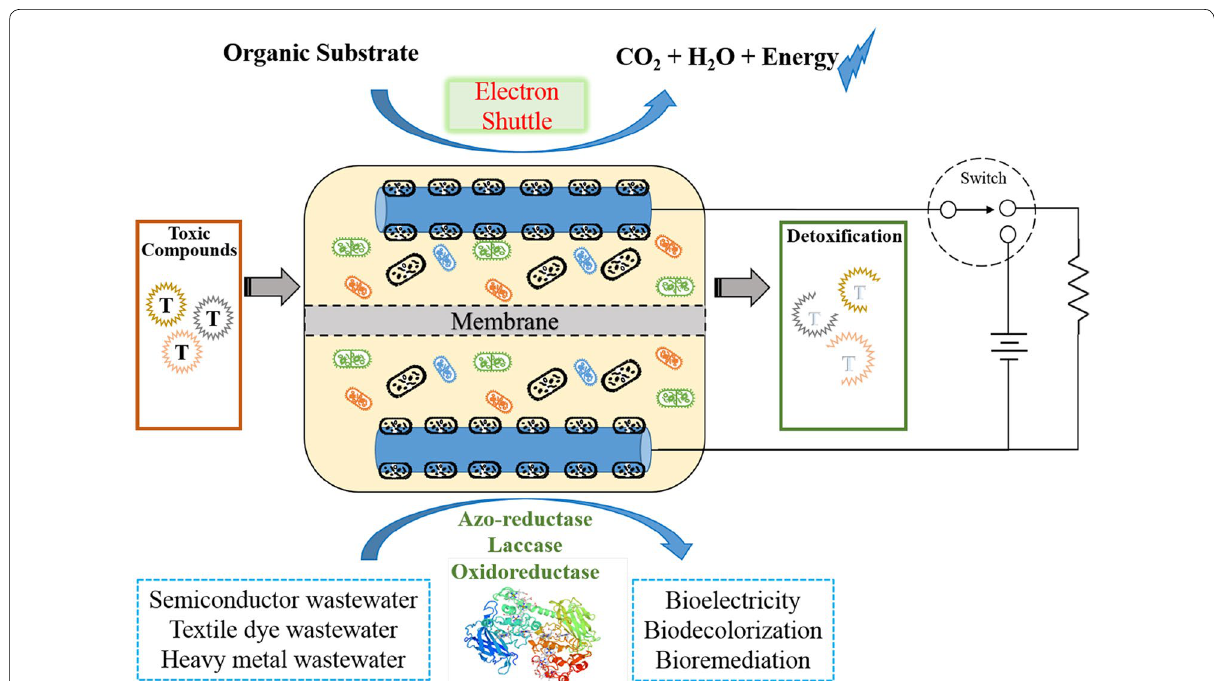
Fig. 6 Proposed microbial fuel/electrolysis cell technology via electro‑fermentation for wastewater treatment. Due to applications of electric current to achieve new redox balancing, electrochemically steered wastewater treatment for bioelectricity generation, dye decolorization, and pol‑ lutant bioremediation could be obtained via such biorefinery/bioenergy‑assisted bioprocesses.